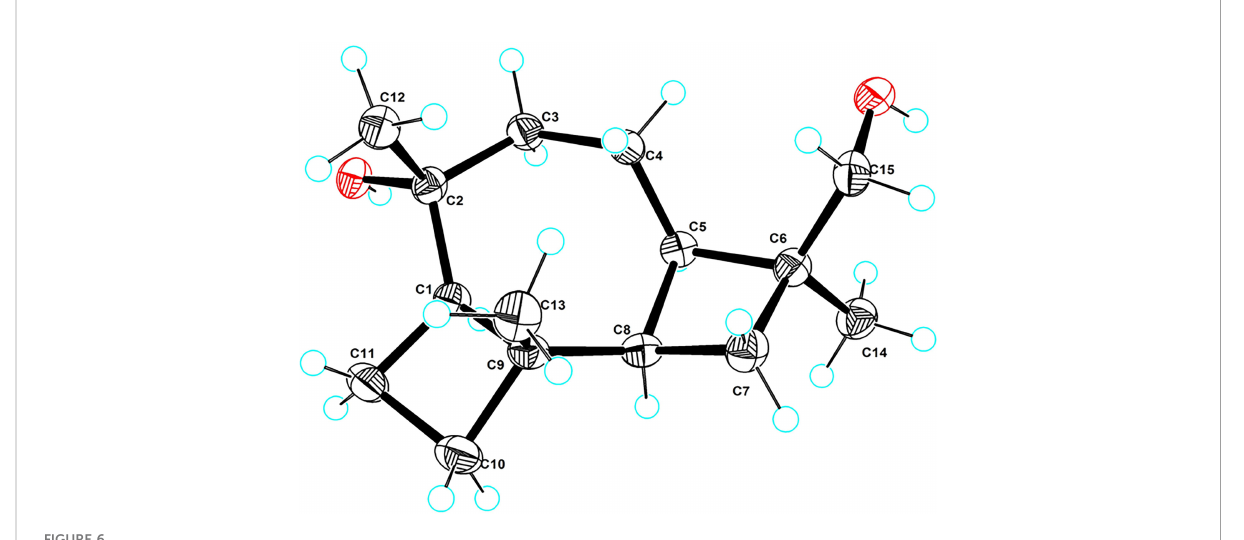
FIGURE 6 ORTEP drawing of the X-ray structure of 5